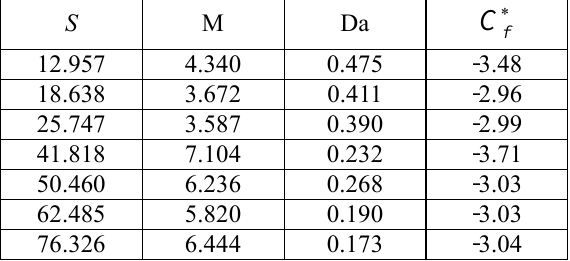
Fig. 6. Effects of nanoparticle fraction on the flow velocity of the fluid. Skin friction for different squeezing, Hartmann and Darcy numbers